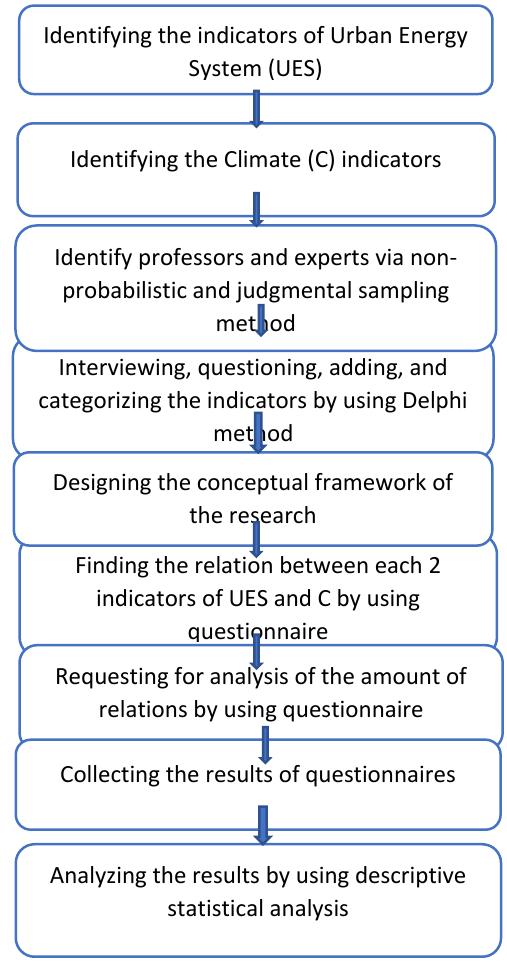
Fig.1: Methodology